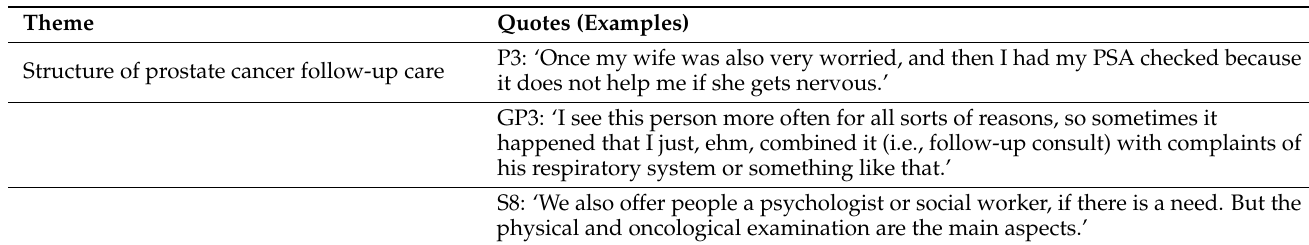
Table 4. Quotes of patients, GPs, and specialists about primary care-based prostate cancer follow-up according to the themes from the transcript